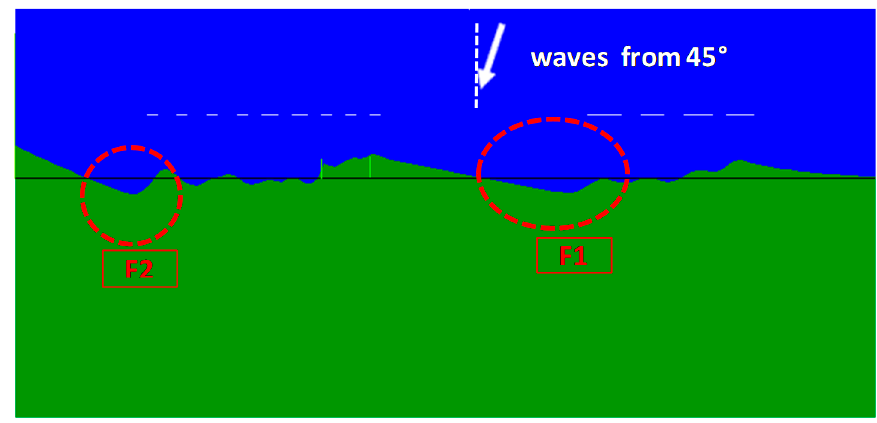
◦ N wave E4 to a 45